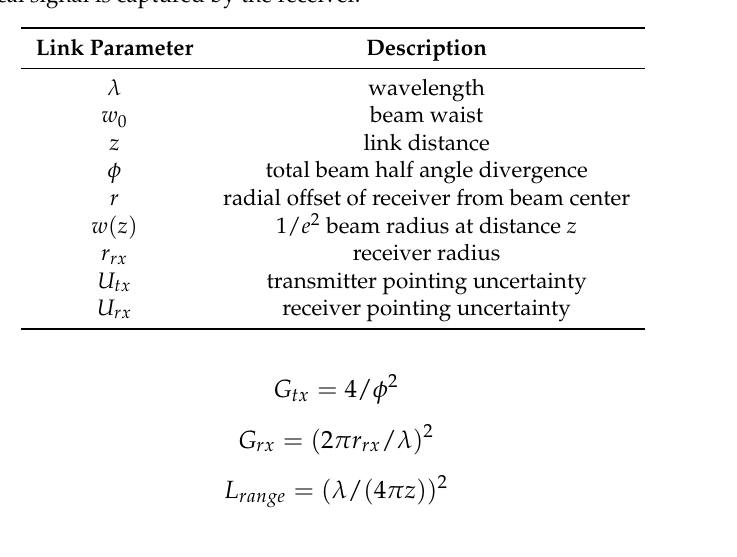
Table A1. The link parameters, or inputs, for the link budget that are used to predict how much of the transmitted optical signal is captured by the